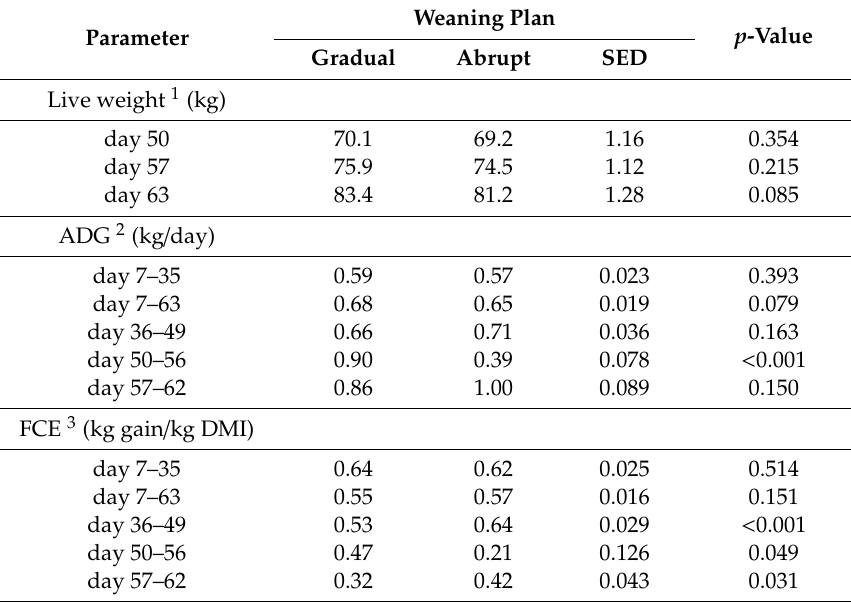
Table 4. Live weight, average daily gain, feed conversion e ffi ciency and total feed costs of calves allocated to either a gradual or abrupt weaning protocol. Weaning Plan p -Value Parameter Gradual Abrupt SED Live weight 1 (kg) day 50